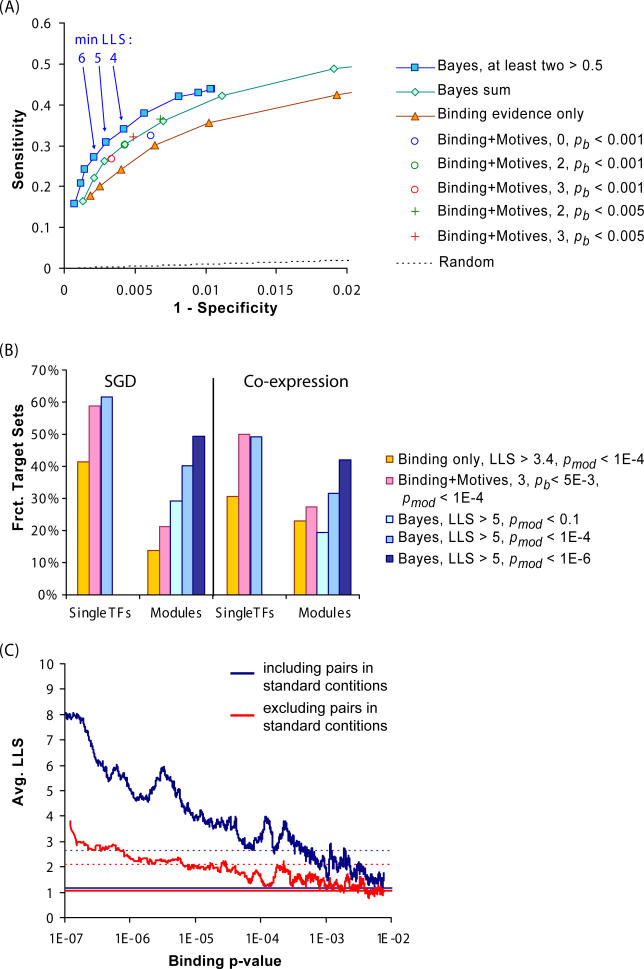
Quality Assessment of the Predicted TF–Target Gene Interactions(A) ROC curves are average of two cross-validations (see Materials and Methods). Lines show specificity and sensitivity accounting for binding evidence only and for integrating all evidences based on the Bayesian approach (with and without [“Bayes sum”] additional filtering). Additional filtering requires that at least two evidences have LLS > 0.5 (see Materials and Methods). Single points refer to previous selections [11] based on binding evidence (chIP-chip, pb < 0.001, pb < 0.005) and motif presence in zero, two, or three yeast species, respectively. Blue arrows indicate the respective LLS thresholds.(B) Target gene sets were validated against Gene Ontology categories taken from SGD [31] and clusters of coexpressed genes (see Materials and Methods). In the latter case, all evidences based on expression data were excluded when assigning TFs to targets. The vertical bars indicate the fractions of TFs or TF modules for which the target genes significantly overlap with at least one category or cluster (p < 10−4, hypergeometric distribution). The filtering criteria for the three sets of predicted interactions were chosen such that all selections have the same specificity (0.995). Yellow indicates using binding p-values as the sole selection criterion; green, selections by Harbison et al. [11] based on binding motifs conserved in at least three species and with binding p-values (pb) < 0.005; and blue, combining all possible lines of evidence; at least two predicted LLSs must be > 0.5; the sum of all evidences must yield a LLS > 5. All modules are significant with p
mod < 10−4, except for the light and dark blue bars (p
mod < 0.1 and < 10−6, respectively). The p
mod does not apply to the single TFs.(C) LLSs were determined based on all evidences, but excluding binding under nonstandard conditions. The average LLS (sliding window) is plotted versus binding p-values under nonstandard conditions. Blue line indicates all TF–target pairs; red line, subset excluding pairs binding under standard conditions (i.e., LLS is exclusively based on evidences other than binding). Horizontal lines indicate global average LLS (solid lines) and average plus one standard deviation (dashed lines).